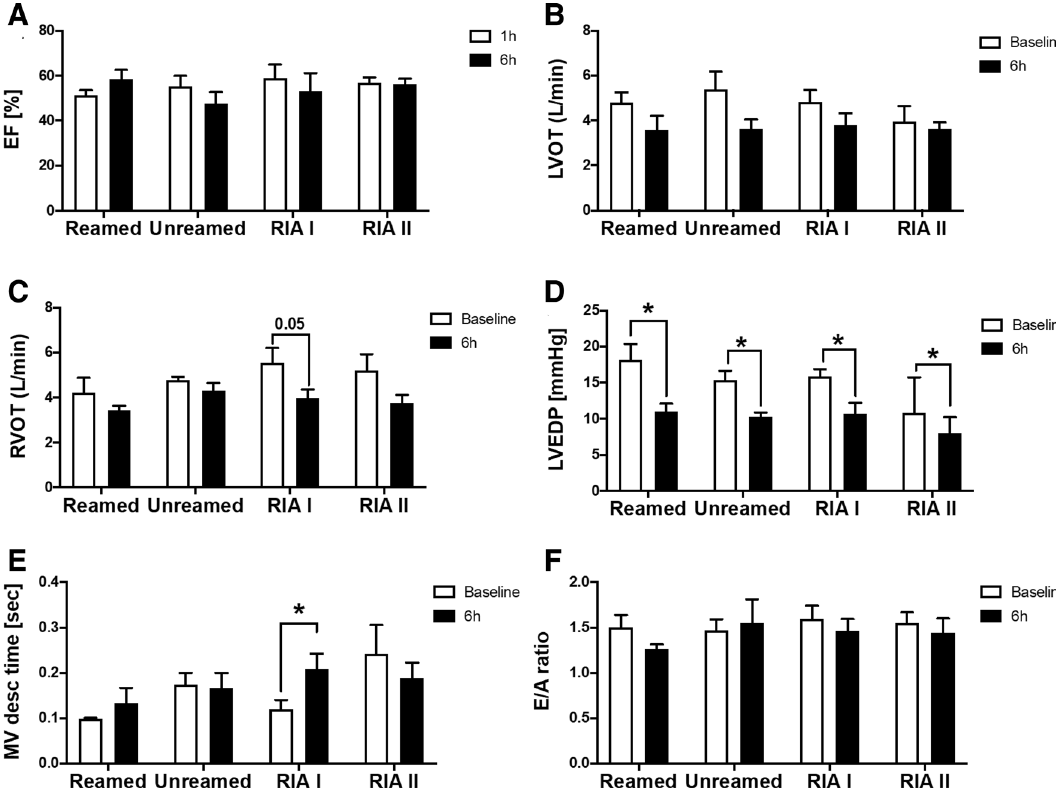
Figure 2. Systolic and Diastolic alterations after fracture: ( A ) Ejection fraction in % measured by Echocardiography at Baseline (white) and 6 h after femur fracture (black) in pigs and either nailing (reamed) reaming (reamed), Reamer-Irrigator-Aspirator 1 (RIA1) or RIA 2. ( B ) Left ventricular outflow tract Cardiac Output in l/min after femur fracture. ( C ) Right ventricular outflow tract cardiac output in l/min. ( D ) Left ventricular end-diastolic pressure (LVEDP) in mmHg bevor and after femur fracture. ( E ) Mitral Valve deceleration time (MV desc time) in sec after femur fracture in pigs compared to baseline. ( F ) Ratio of E to A wave detected amongst the mitral valve (E/A). n = 5 in each group, data were presented as ± SEM, *p ≤ 0.05.